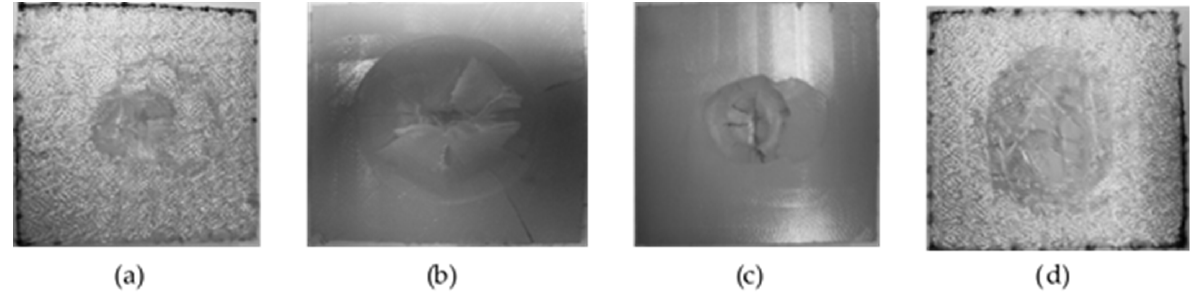
Figure 14. Impact samples on PA-PA86 composite. ( a ) Impact face on sample with ejector side impact. ( b ) Opposite impact face on sample with ejector side impact. ( c ) Impact face on sample with injection side impact. ( d ) Opposite impact face on sample with injection side impact.